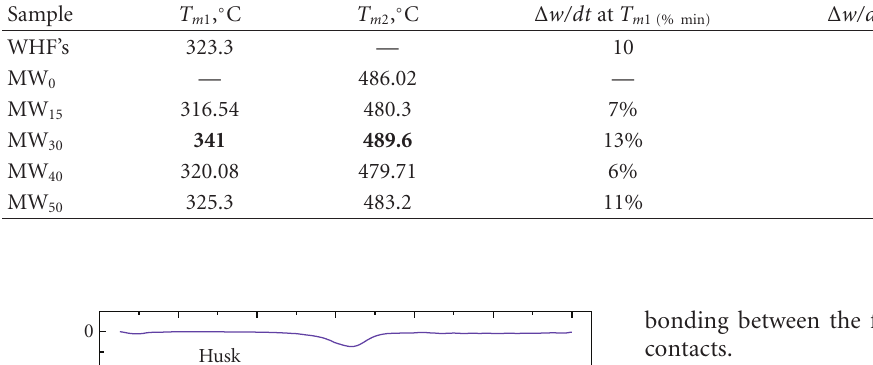
Table 6: Analysis of the thermograms of WHF, EPDM, and WHF-EPDM vulcanizates at the heating rate of 10 ◦ C/min. Sample